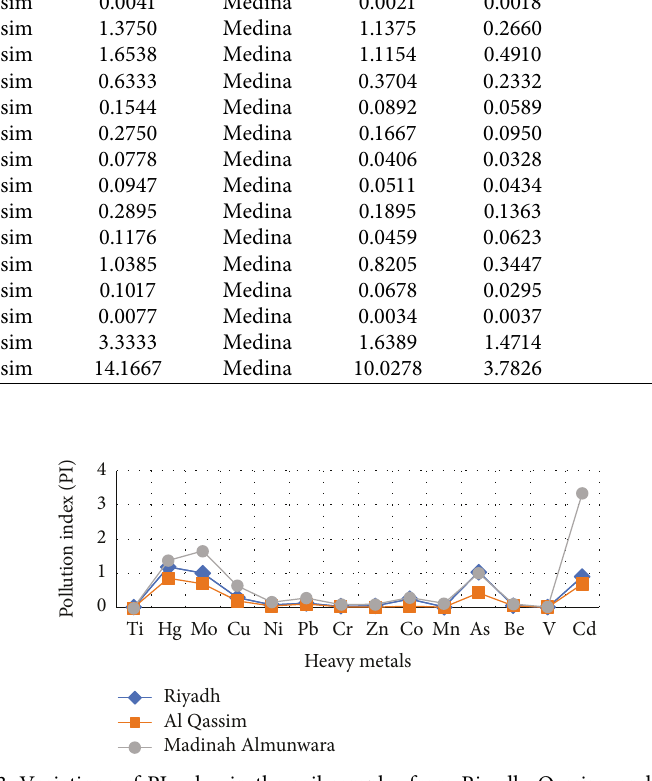
Table 5: Results of pollution indexes of Riyadh, Qassim, and Medina regions soil treated with sewage water. Element